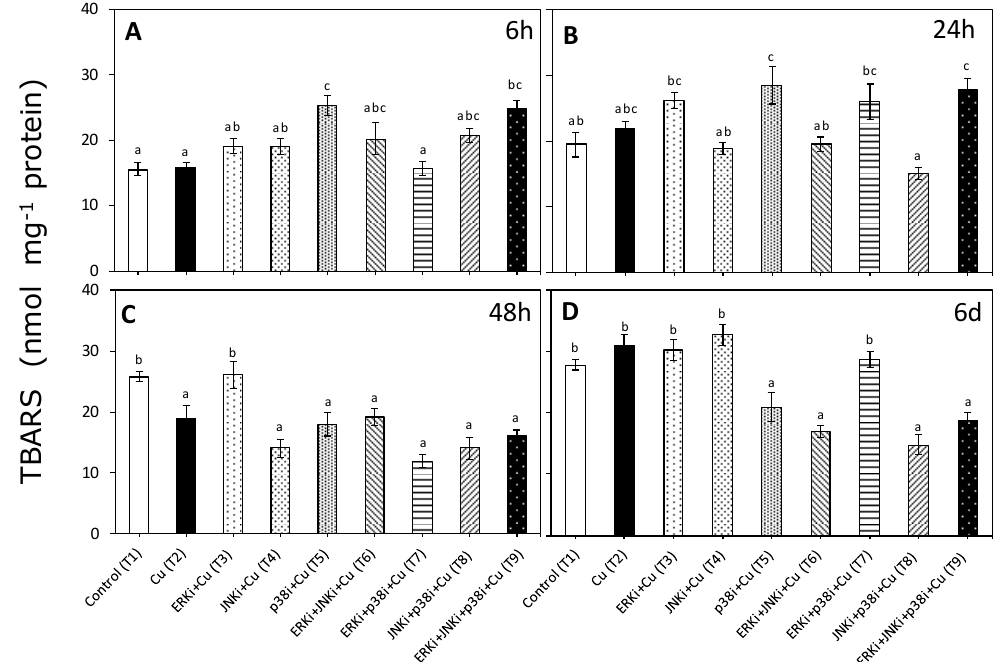
Figure 2. Thiobarbituric acid reactive substances (TBARS) accumulation in U. compressa under copper and/or exposure to MAPK inhibitors. Treatments consisted in: T1) control only with seawater; T2) solely copper exposure as 10 µM of CuSO 4 (Cu); T3) copper + 5 µM MAPK ERK inhibitor PD98059 (Cu + ERKi); T4) copper + 5 µM MAPK JNK inhibitor SP600125 (Cu + JNKi); T5) copper + MAPK p38 inhibitor SB203580 (Cu + p38i); T6) Cu + ERKi + JNKi; T7) Cu + ERKi + p38i; T8) Cu + p38i + JNKi; and T9) Cu + ERKi + JNKi + p38i. Samples were analyzed after 6 h ( A ), 24 h ( B ), 48 h ( C ) and 6 d ( D ) treatments. Different letters represent significant difference at 95% confidence interval ( p < 0.05). Plots are represented as mean ± SE ( n =